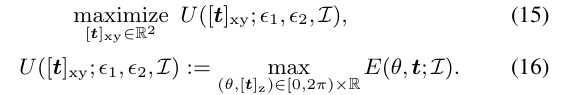
Algorithm 1 for Problem 1.